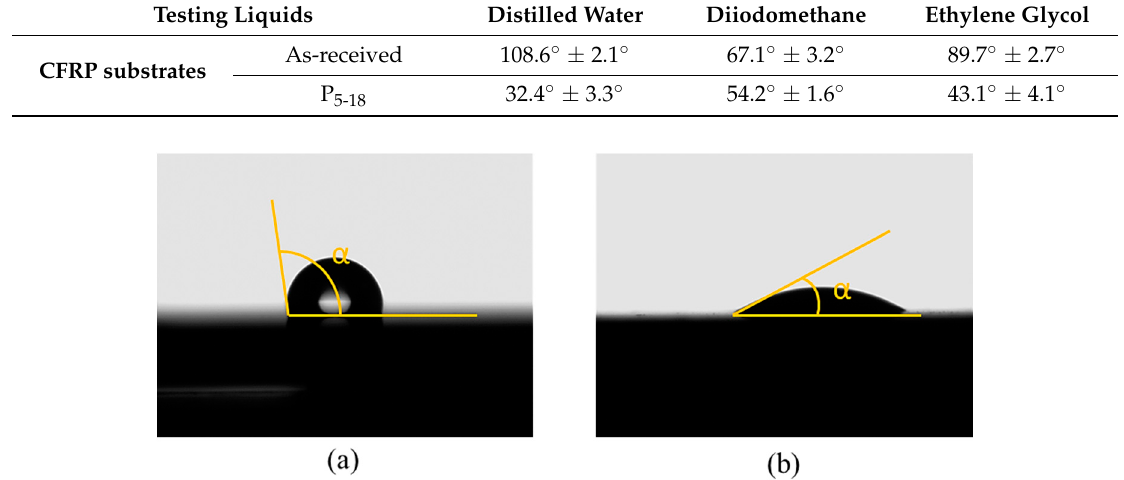
Table 8. Measured contact angles of the as-received and P 5-18 CFRP substrates.